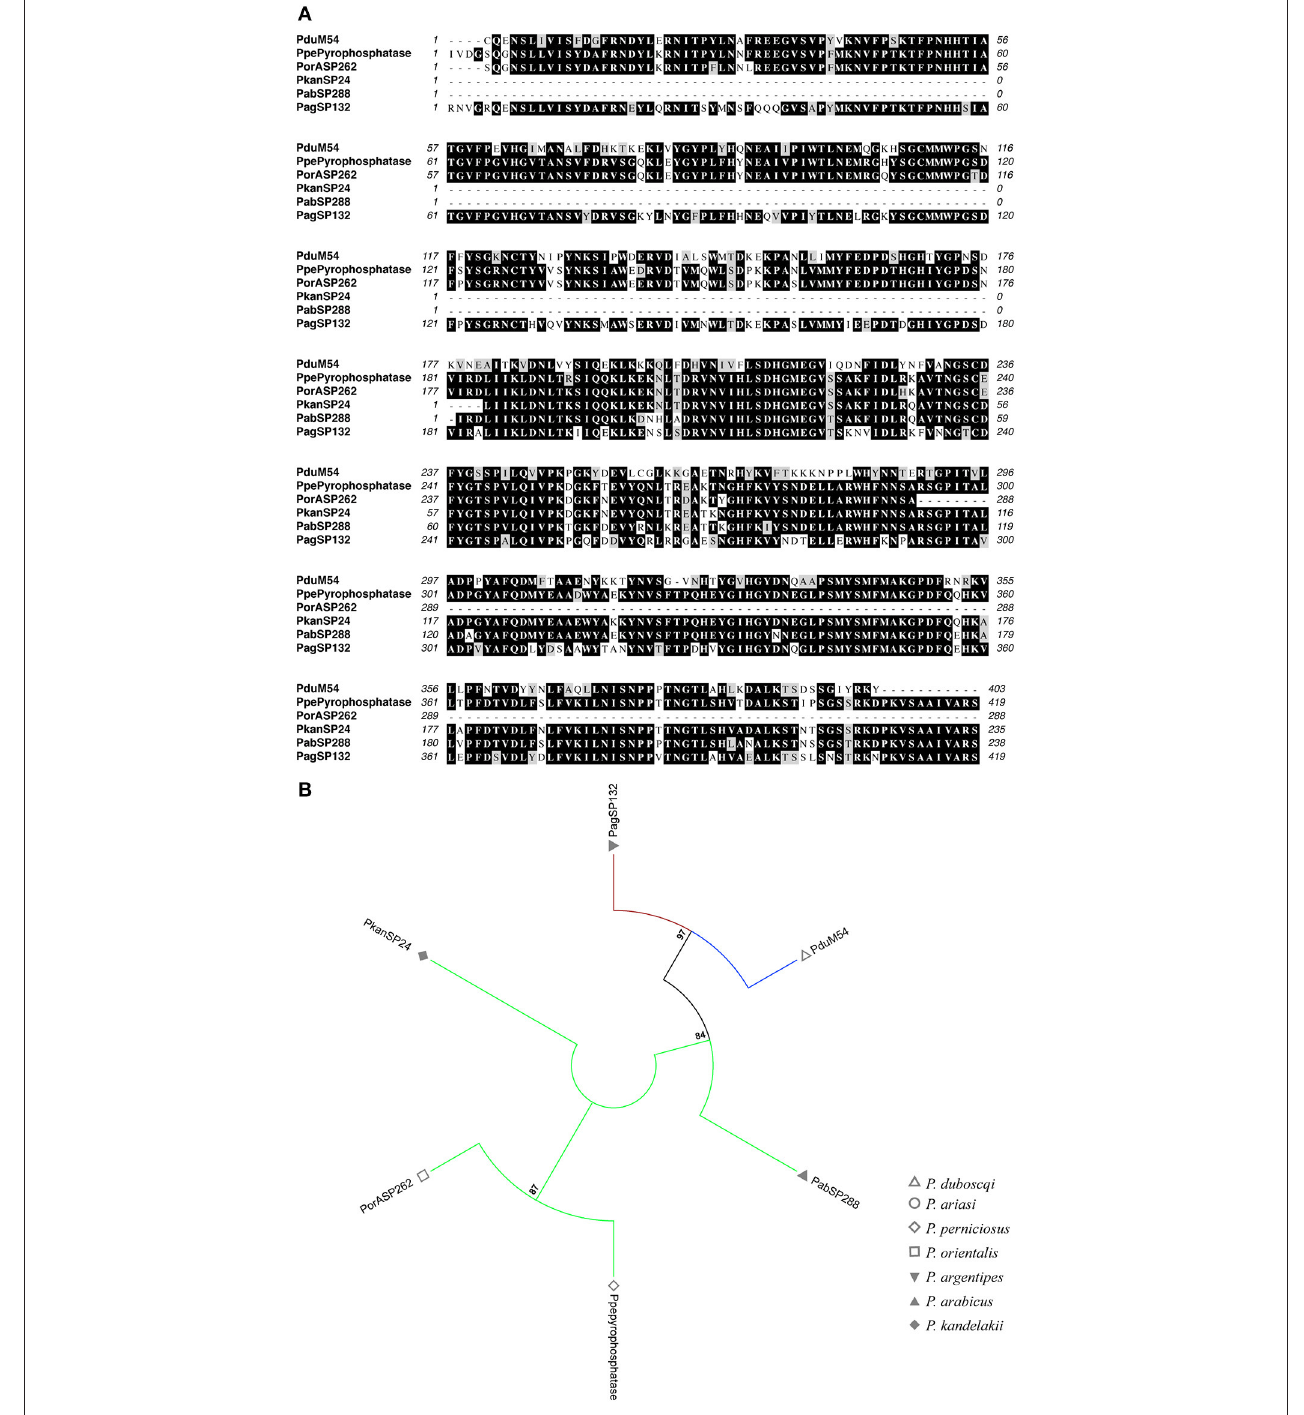
FIGURE 10 | Multiple sequence alignment and molecular phylogenetic analysis of the sand fly Pyrophosphatase salivary protein family. (A) Multiple sequence alignment of Pyrophosphatase A2 proteins . PduM54 ( P. duboscqi ), PpePyrophosphatase ( P. perniciosus ), PorASP262 ( P. orientalis ), PkanSP24 ( P. kandelakki ), PabSP288 ( P. arabicus ), and PagSP132 ( P. argentipes ). Black background shading represents identical amino acids. Gray background shading represents similar amino acids. (B) The evolutionary history of Pyrophosphatase salivary protein family was inferred by using the Maximum Likelihood method based on the Whelan And Goldman model (Whelan and Goldman, 2001). Sand fly species are indicated by the different symbols in the legend on the right. Tree branches were color-coded so as to represent specific taxon: Green color represents the Larroussius and Adlerius subgenera; Red color indicates the Euphlebotomus subgenus; Blue color points to proteins of the Phlebotomus and Paraphlebotomus subgenera.